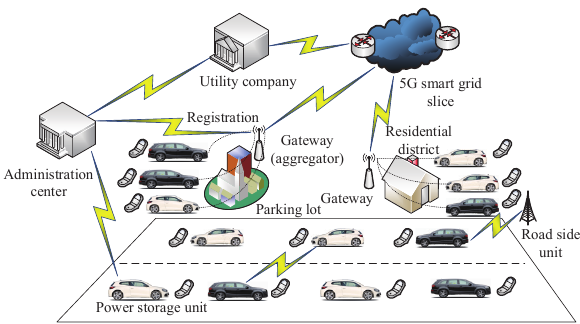
Figure 6. The architecture of the secure communication and power injection scheme.